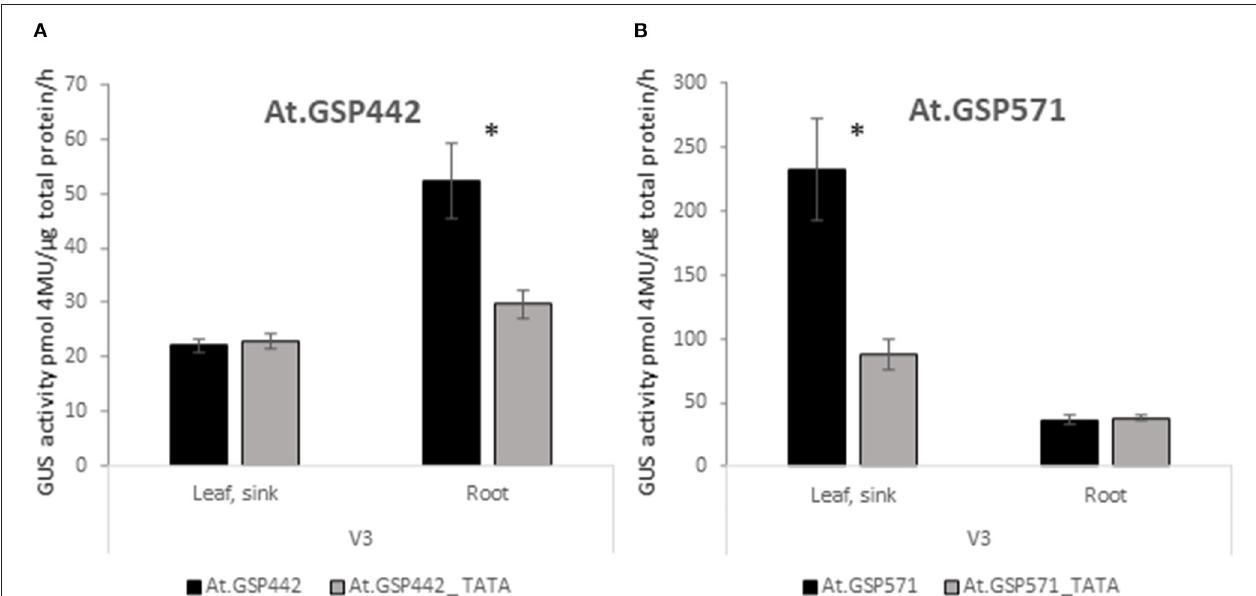
FIGURE 4 | GSPs require the TATA box for function. Expression of GUS reporter genes with TATA box variants of GSPs was compared to original At.GSP442 (A) and At.GSP571 (B) promoters. At.GSP442_TATA and At.GSP571_TATA promoter variants were generated by introducing transversions in the TATA boxes of the respective promoters. Promoter variants were tested in the same expression cassette context as the original promoters in Figure 1 . GUS reporter gene activity was performed on leaf and root tissues from transgenic soybean plants at the V3 stage. GUS enzyme activity on MUG substrate was normalized to total protein and reported as pmol 4MU/ µ g total protein/h. At least 12 independent transgenic events were analyzed, and the data are reported as the mean with SE. *Indicates a statistically significant difference between original and TATA variants when compared in the same tissue type with p -value threshold corrections to control for false discovery < 0.05 in multiple